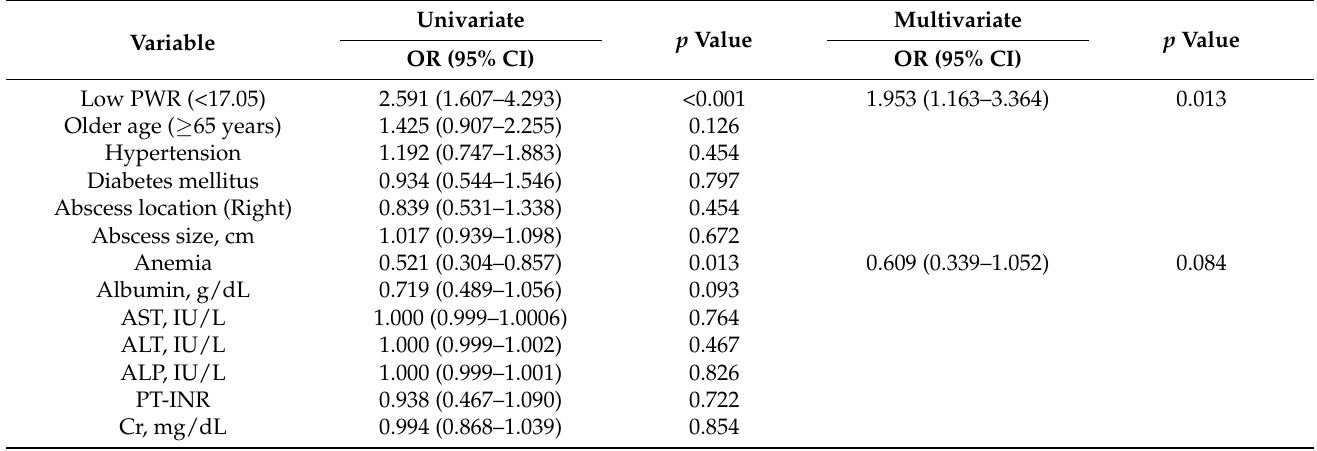
Table 3. Risk factors for metastatic infection in patients with pyogenic liver